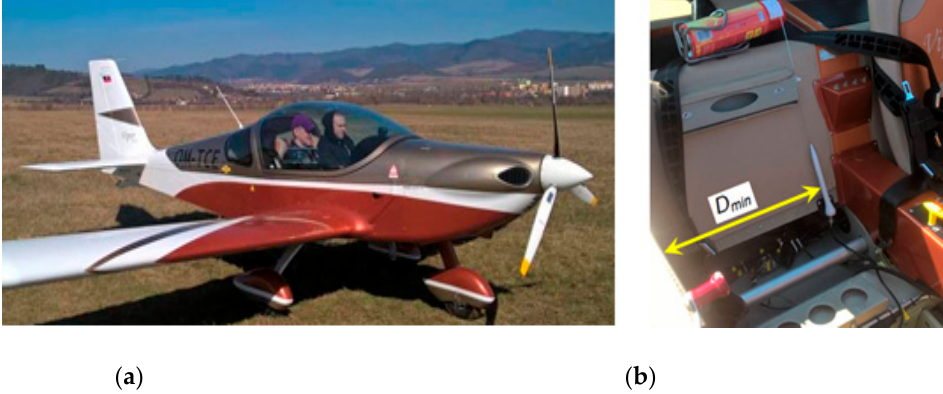
Figure 16. The influence of metal parts of the fuselage on the radiation characteristics; ( a ) the influence of the tail area of aircraft and the rear area of the cockpit; ( b ) the influence of the side wall of the cockpit.